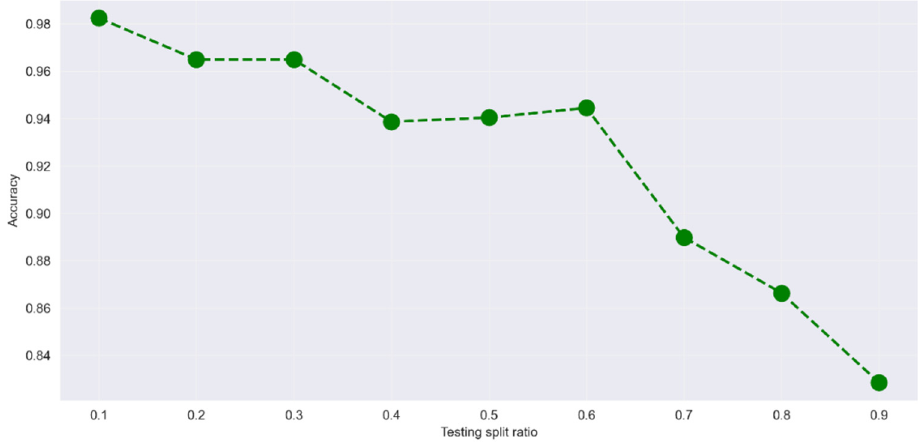
Figure 8. Analysis of testing/training split ratio for the CNN model .